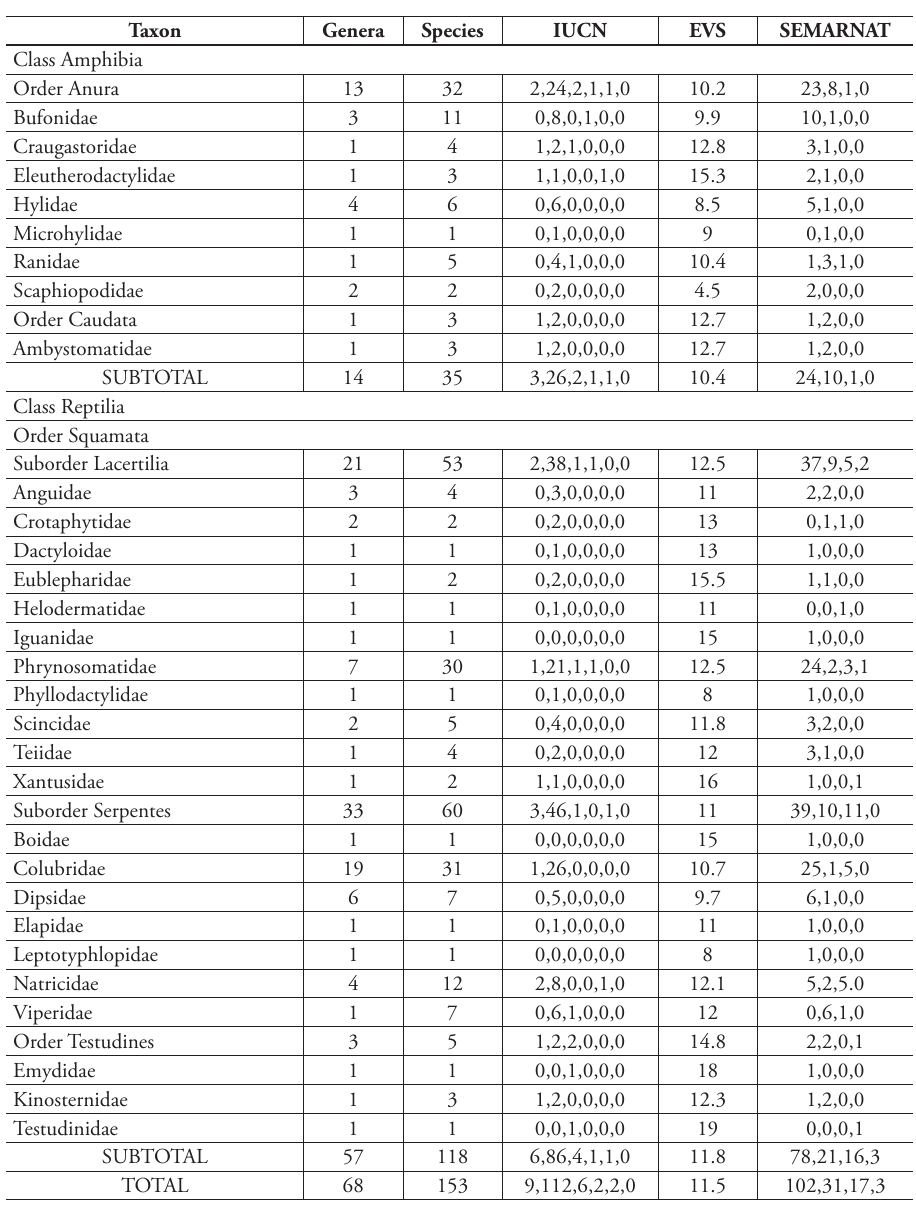
Table 2. Summary of native species present in Durango by Family, Order or Suborder, and Class. Status summary indicates the number of species found in each IUCN conservation status in the order DD, LC, V, NT, E, CE (see Table 1 for abbreviations; in some cases species have not been assigned a status by the IUCN and therefore these may not add up to the total number of species in a taxon). Mean EVS is the mean Environmental Vulnerability Score, scores ≥ 14 are considered high vulnerability (Wilson et al. 2013a,b) and conservation status in Mexico according to SEMARNAT (2010) in the order NL, Pr, A, P (see Table 1 for